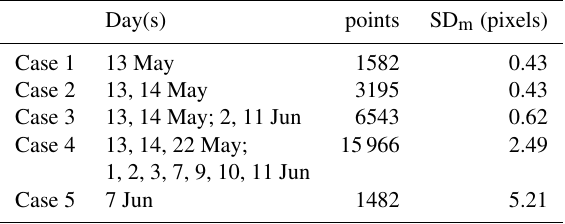
Table 1. Calibration test cases. The days included in each test case are given along with the number of sun position points and an esti- mate of measurement standard deviation SD m which represents the extent to which the data deviate from a smooth arc. See also Fig. 2 and Eq.